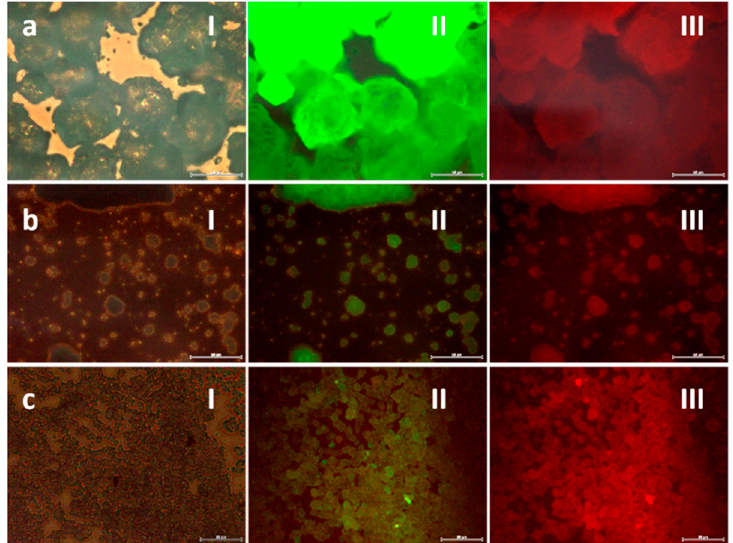
Figure 4. Evolution of the luminescent intensity as followed by fluorescence microscopy. ( a ) Com- mercial SrAlO:Eu,Dy powder (scale bar 50 μ m), ( b ) 13 h milled powder (scale bar 50 μ m), ( c ) as- prepared SrAlO:Eu,Dy@SiO 2 composites (scale bar 20 μ m). Measurements performed in ( I ) bright field channel; ( II ) green channel, λ em = 500–550 nm; and ( III ) red channel, λ em = 570–700 nm; λ ex = 405 nm.